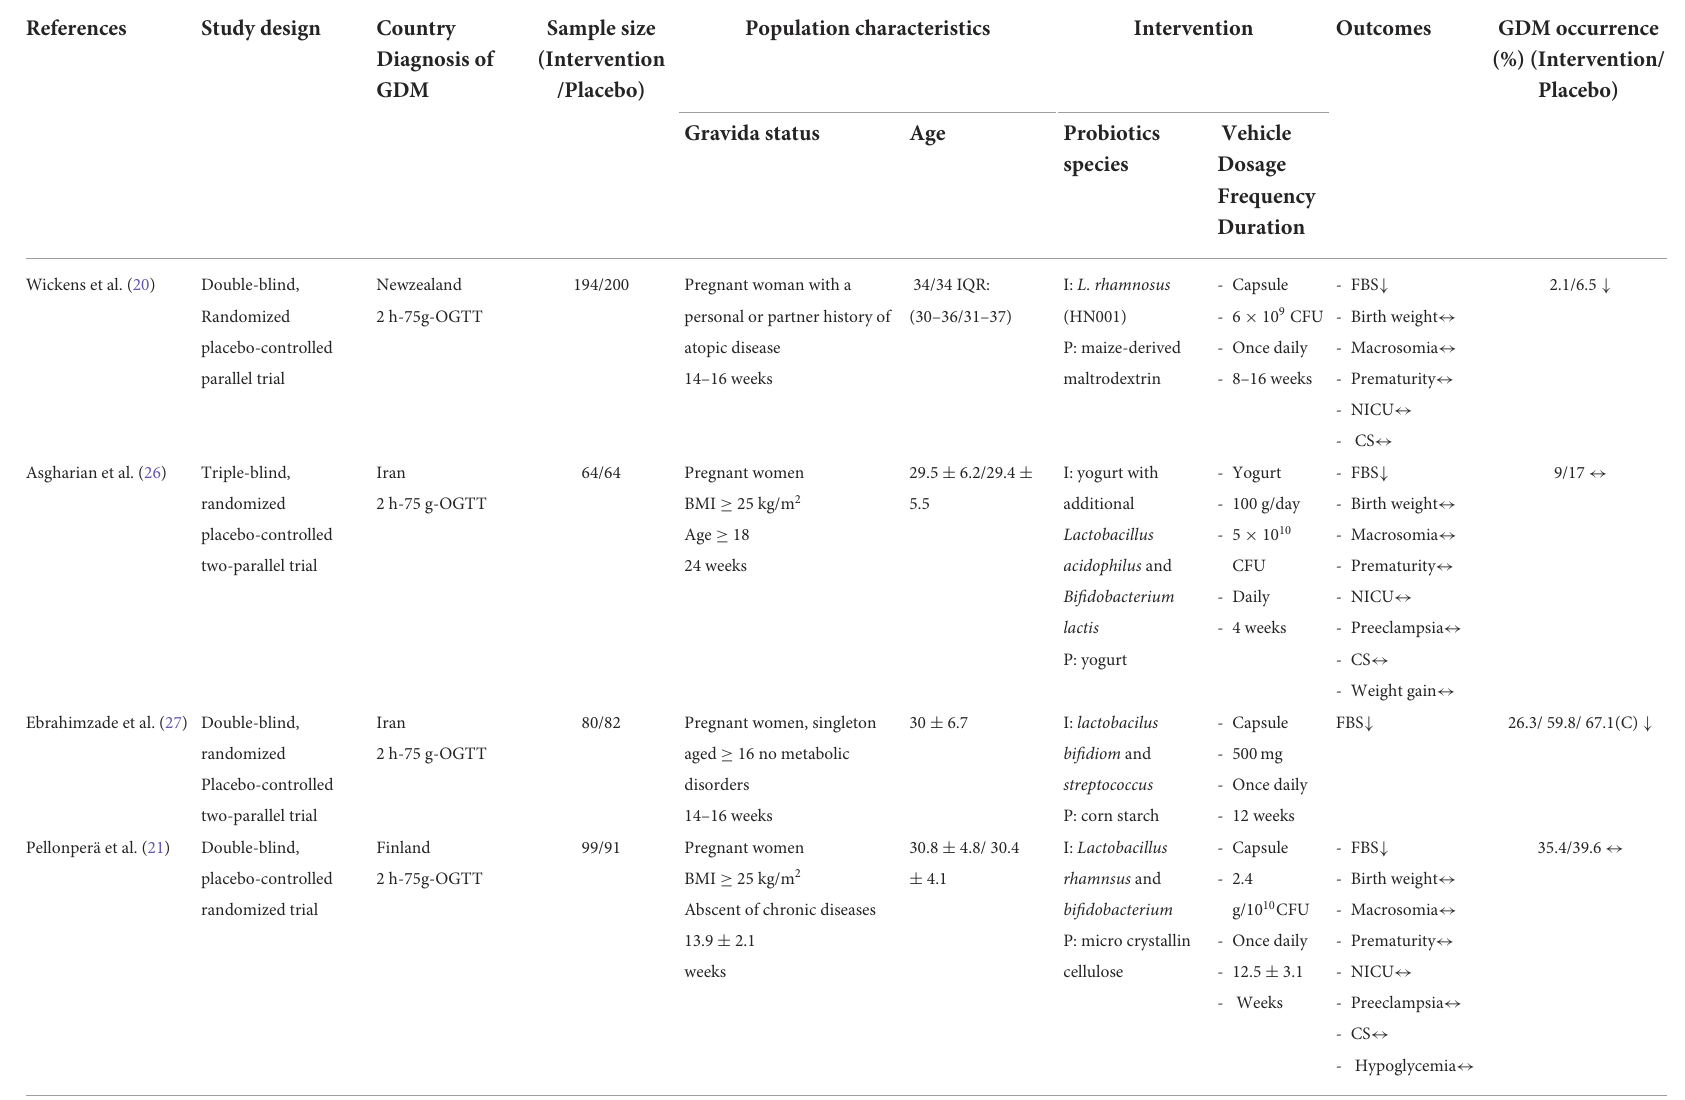
TABLE 1 Characteristics of the included